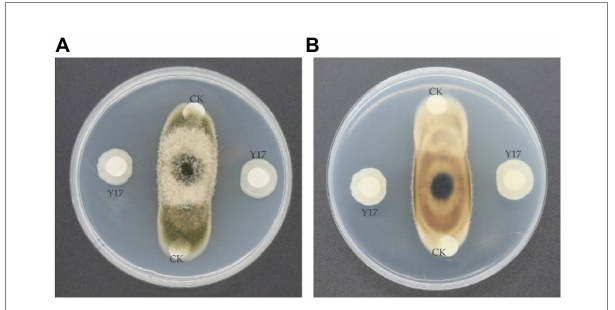
FIGURE 2 Antifungal activity of the Y17B strain against A. alternata . (A,B) Front (A) and reverse (B) side of the dual culture plate 7 dpi. CK, control (only LB medium); Y17, inoculated with Bacillus subtilis